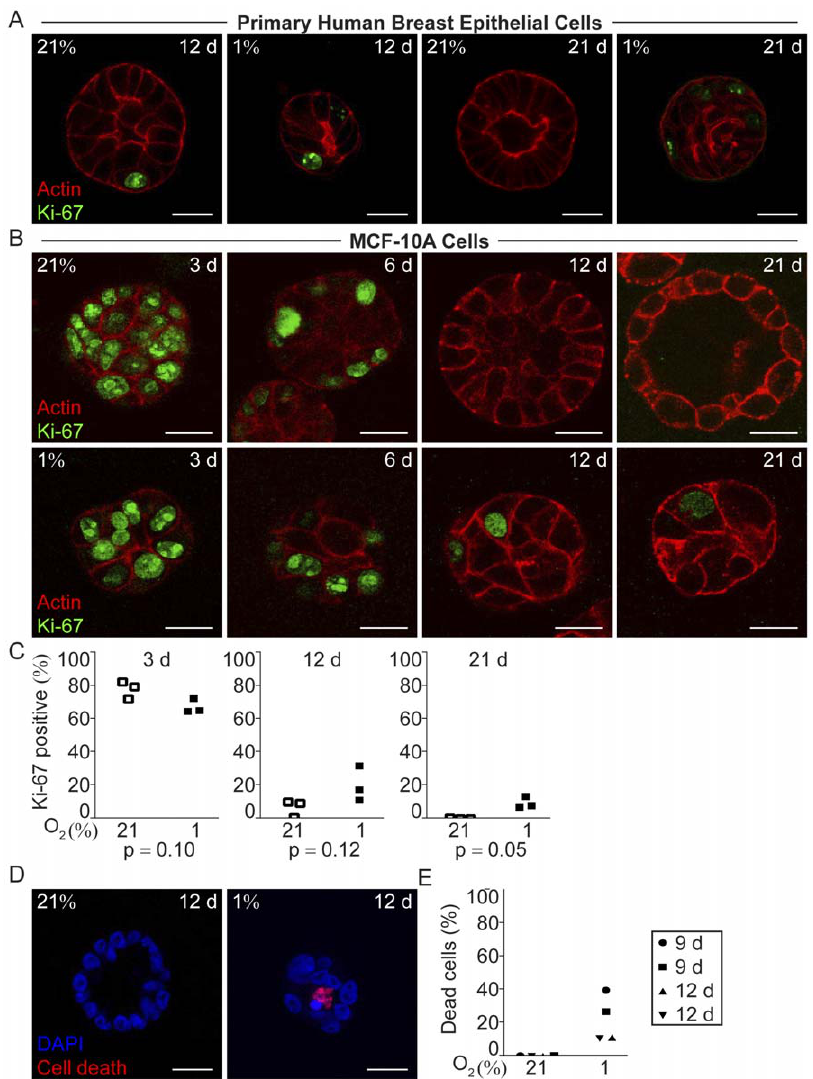
Figure 2. Proliferation and cell death in hypoxic and normoxic 3D-cultures in ECM-derived substrate. A Ki-67 immunofluorescence (green) and actin (red) staining of primary human breast epithelial cells in 3D-culture in ECM-derived substrate at 21% and 1% oxygen for 12, and 21 days. Representative images from one of three independent experiments with breast epithelial cells isolated from different healthy individuals are shown. Size bars 20 m m. B. MCF-10A cells stained for Ki-67 (green) and actin (red) after 3, 6, 12, and 21 days of 3D-culture in ECM-derived substrate under normoxic (21%) or hypoxic (1%) conditions. Representative images from one of three independent experiments are shown. Size bars 20 m m. C. Percentage of cells with Ki-67 positive nuclei in normoxic and hypoxic MCF-10A cell organoids 3, 12, and 21 days post-seeding, in three independent experiments. Statistical analysis was performed with Student’s paired t-test (p). In each experiment at least 200 cells were included in the calculation. D. Cell death in MCF-10A cells grown in 3D-culture under normoxic and hypoxic conditions for 12 days, by in situ cell death detection (red), nuclear staining with DAPI (blue). All confocal micrographs were acquired at the Z-plane where the depictured acini-like structure had the widest circumference. Size bars 20 m m. E. Percentage of cells with nuclei positive for in situ cell death detection in normoxic (21%) and hypoxic (1%) 3D- cultures at 9 and 12 days post-seeding. Data from four experiments are shown. In each experiment at least 200 cells were included in the calculation.